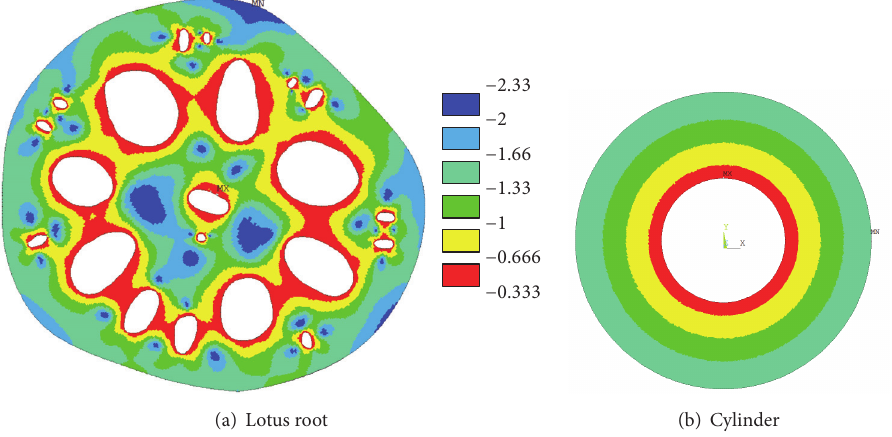
Figure 9: Triaxiality factors in the cross-sectional